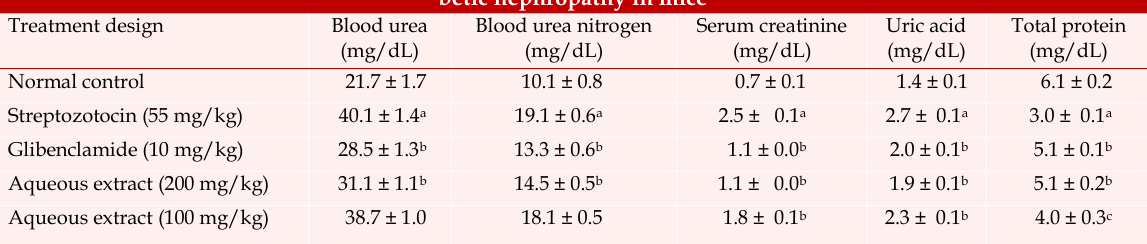
Effect of aqueous extract of leaves of Sechium edule on biochemical parameters in streptozotocin-induced